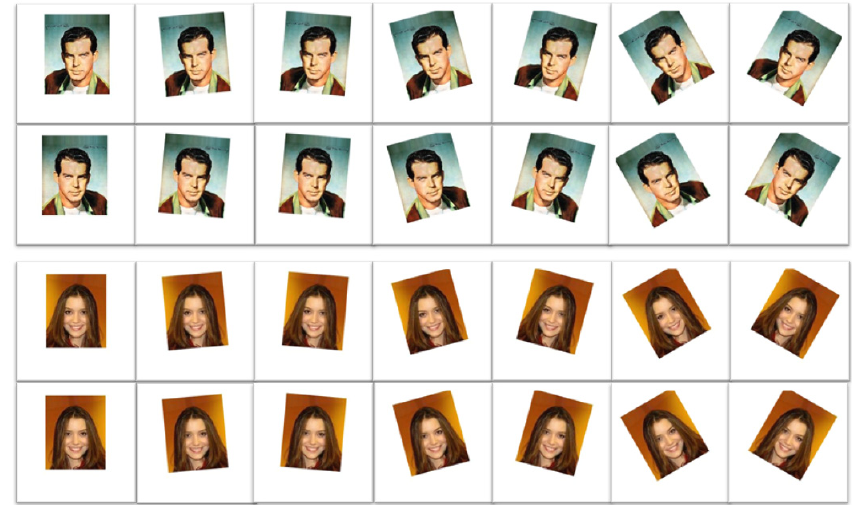
Figure 2. Example of data augmentation.